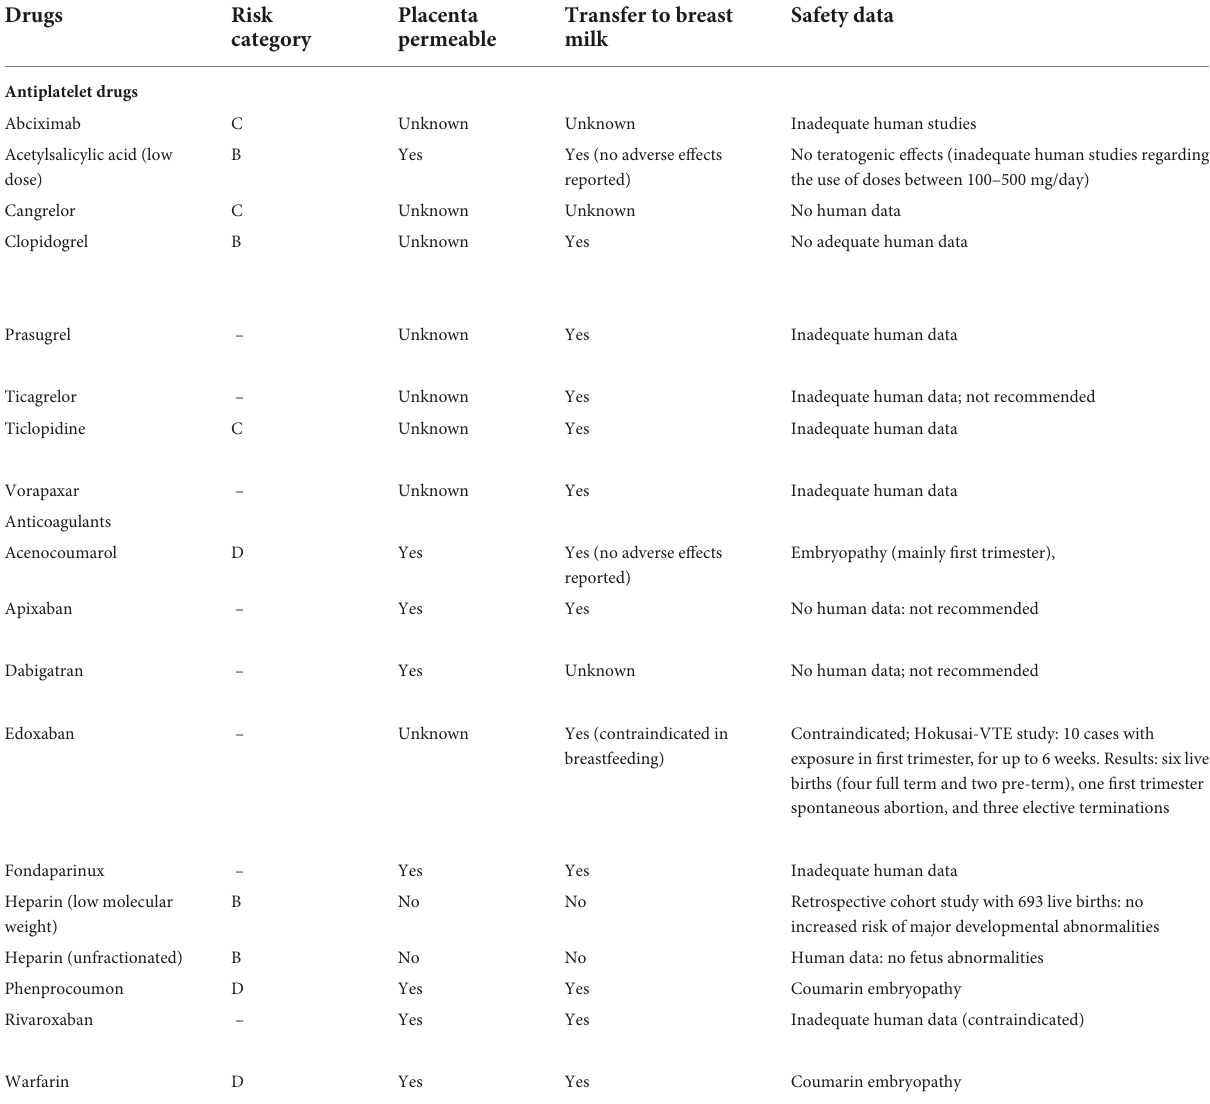
TABLE 3 Safety of anti-thrombotic drugs during pregnancy and